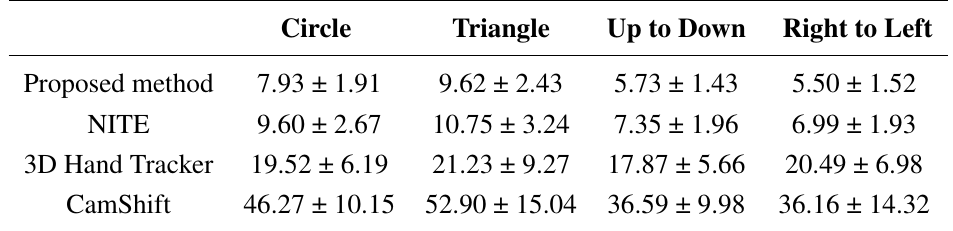
Table 4. Averaged errors in the pixel of our proposed method in comparison with NITE, 3D Hand Tracker with depth images and CamShift, for different hand motions (circle, triangle, up to down and right to